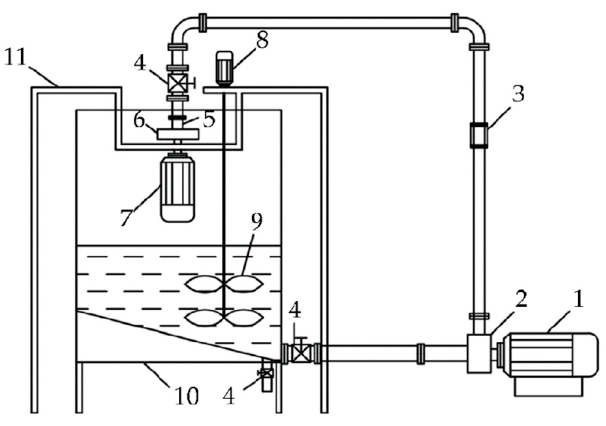
Figure 1. Schematic view of the experimental bench system. 1. Motor; 2. pump; 3. electromagnetic flow meter; 4. valve; 5. sliding bearing; 6. rotating disc; 7. frequency conversion motor; 8. stirring motor; 9. stirrer; 10. water storage tank; 11. motor support.